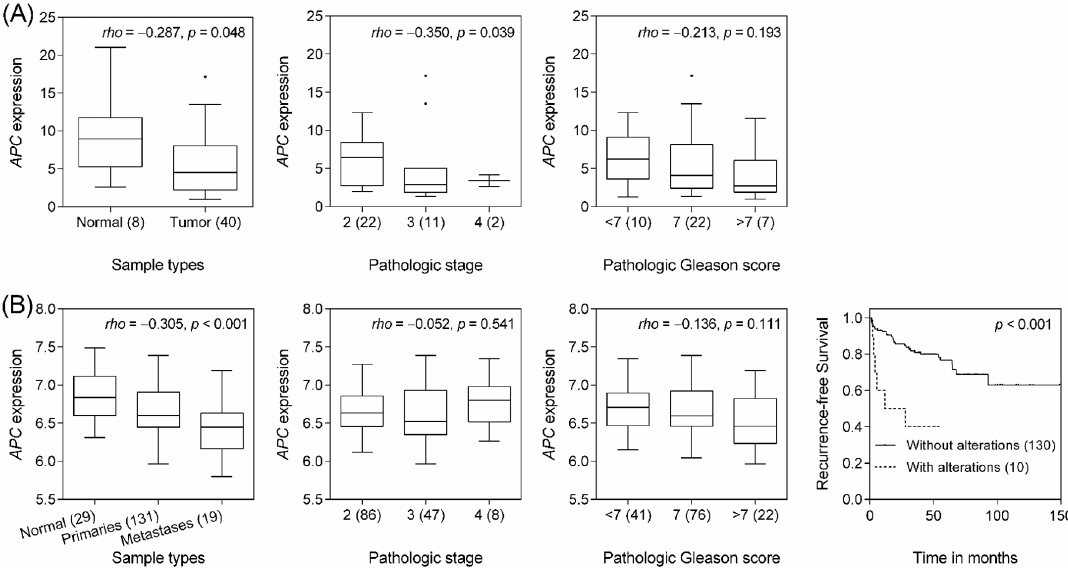
Figure 3. Correlation of APC mRNA expression with prostate cancer progression. ( A ) APC mRNA expression in 40 prostate cancers and eight normal human prostate tissue specimens, as determined by qRT-PCR, indicates that APC is downregulated in the cancer tissues, especially in those from patients with more advanced stages of cancer; ( B ) The associations between APC expression and prostate cancer aggressiveness were analyzed using an independent set of Memorial Sloan-Kettering Cancer Center Prostate Oncogenome data. Primary and metastatic prostate cancers display significantly lower APC mRNA expression. rho , Spearman’s rank correlation coefficient. Data points beyond the quartiles are outliers. Kaplan-Meier curves of recurrence-free survival according to the alterations in APC are shown. Patients were dichotomized with or without APC homozygous deletion, mutation and mRNA downregulation. Numbers in parentheses indicate the number of patients.